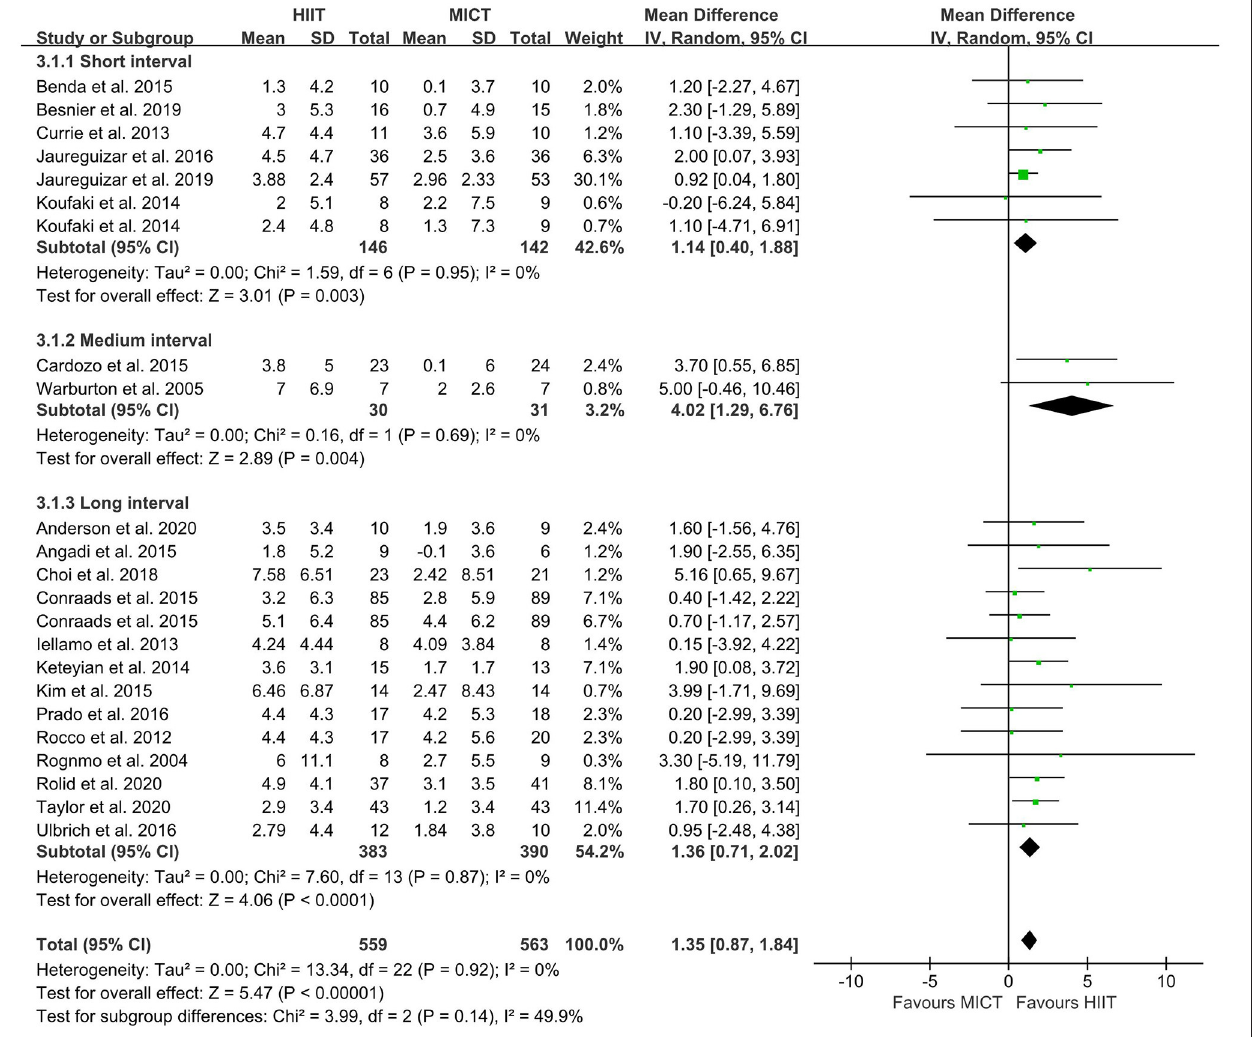
FIGURE 4 | Forest plot of subgroup analysis by a different model of HIIT (short-interval, medium-interval and long-interval HIIT). HIIT, high-intensity interval training; MICT, moderate-intensity continuous